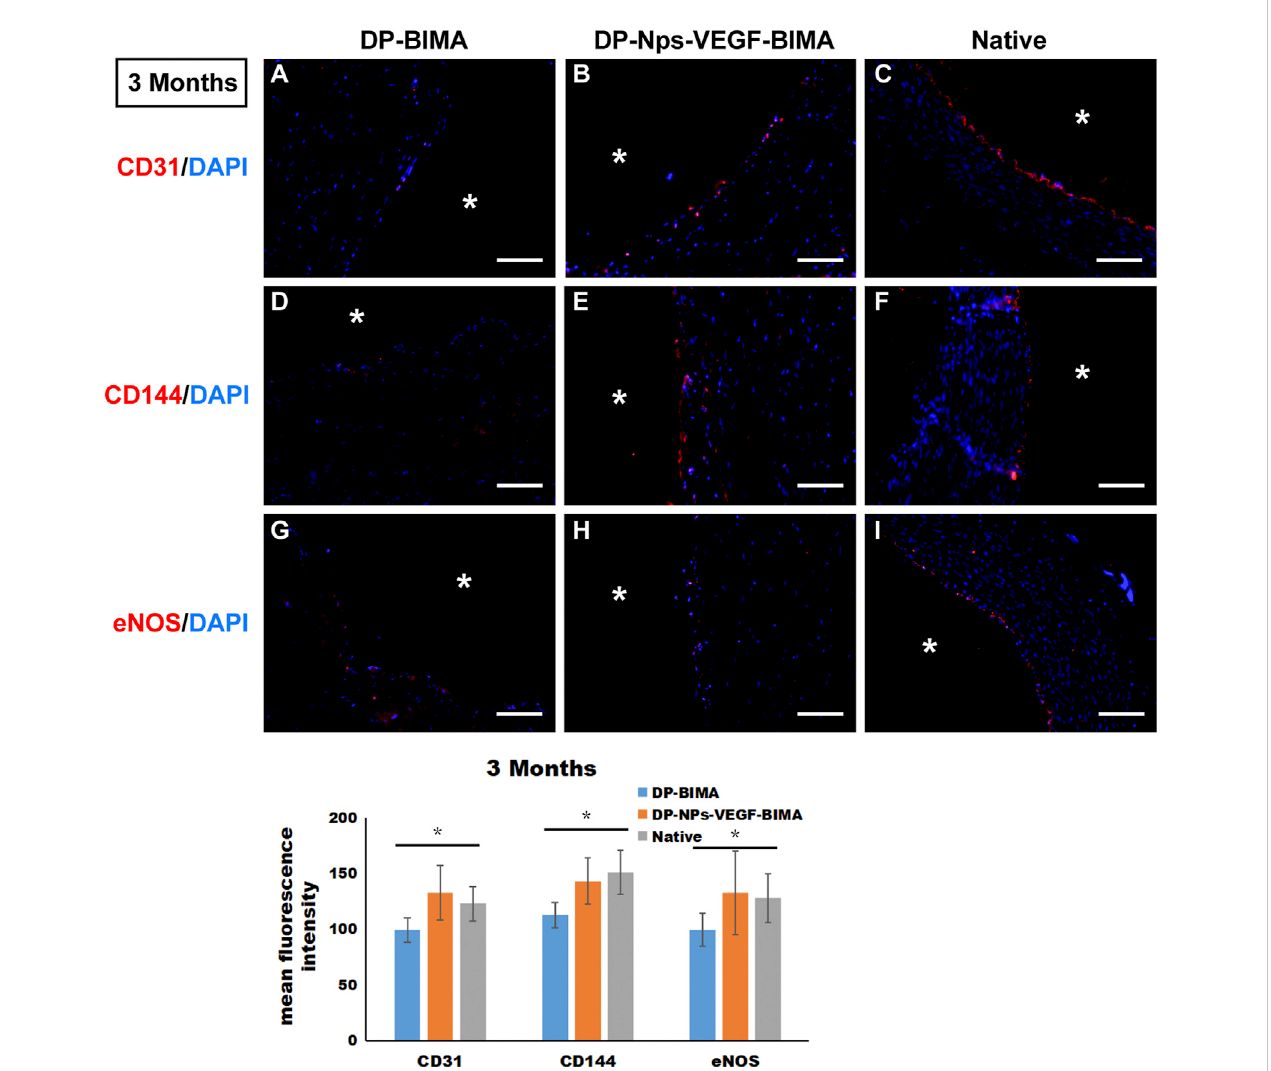
FIGURE 11 The immuno fl uorescent staining results of CD31, CD144, and eNOS. Samples are native rabbit aorta, and the grafts of the two groups which were implanted for 3 months. (A – C) were the staining of CD31 and DAPI for DP-BIMA, DP-Nps-VEGF-BIMA, and native rabbit aorta, respectively. (D – F) were the staining of CD144 and DAPI for DP-BIMA, DP-Nps-VEGF-BIMA, and native rabbit aorta, respectively. (G – I) were the staining of eNOS and DAPI for DP-BIMA, DP-Nps-VEGF-BIMA, and native rabbit aorta, respectively.* indicates the lumen of the grafts. Scale bars indicate 100 μ